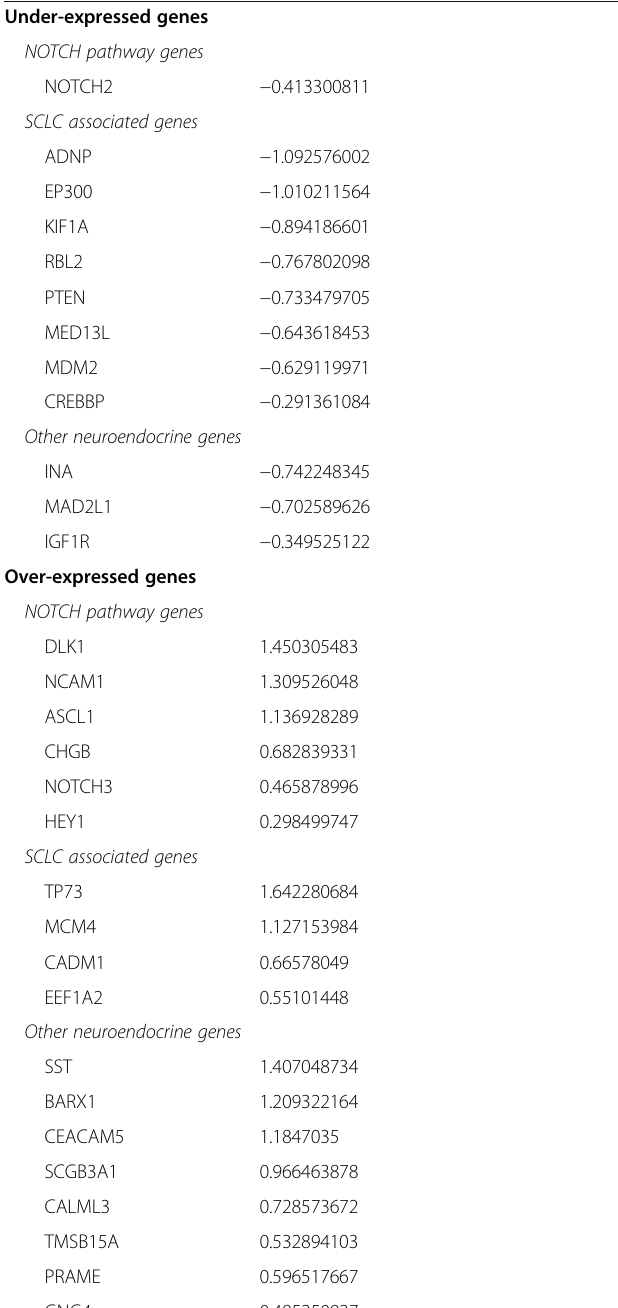
Table 3 Genes associated with neuroendocrine differentiation that showed differential expression in neuroendocrine positive areas in basaloid squamous cell carcinoma samples Change in expression (mean log 2 fold-change) # of samples with differential expression ( n =